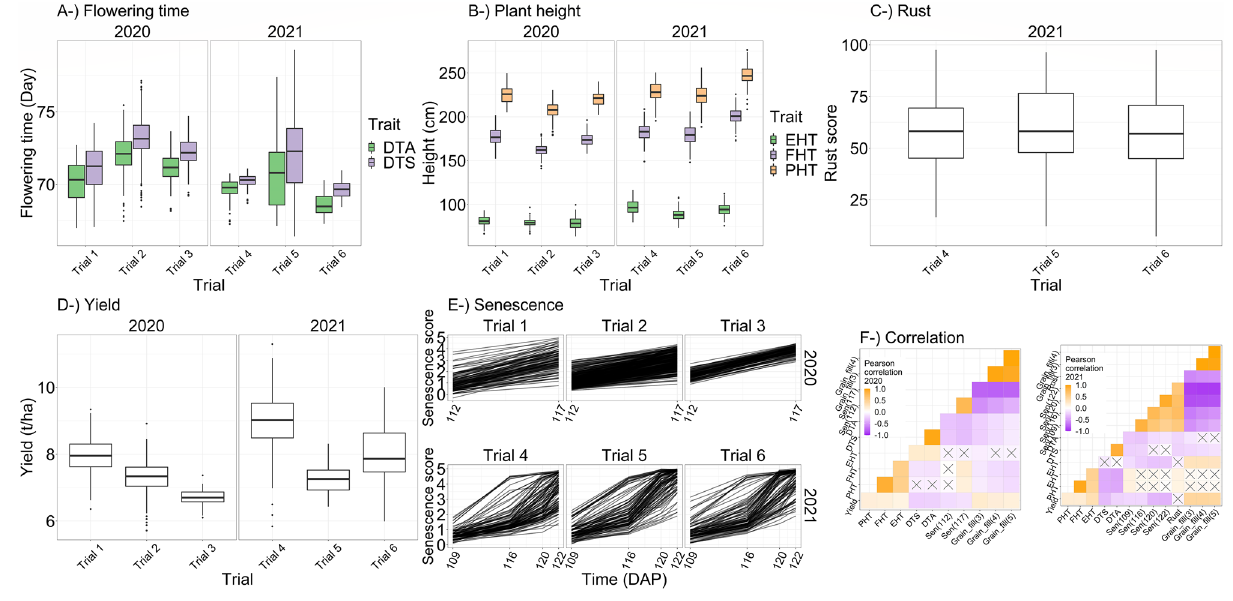
Figure 7. Predicted hybrid values of ( A ) flowering times (days to anthesis and silking: DTA and DTS), ( B ) three different plant heights (plant heights from ground to tip of tassel: PHT, to collar of flag leaf: FHT, and to shank of first ear: EHT), ( C ) rust, ( D ) yield, and ( E ) senescence in each trial in both years. ( F ) Pearson correlation coefficients were given that were calculated among all predicted traits including three different grain fill traits in each year.